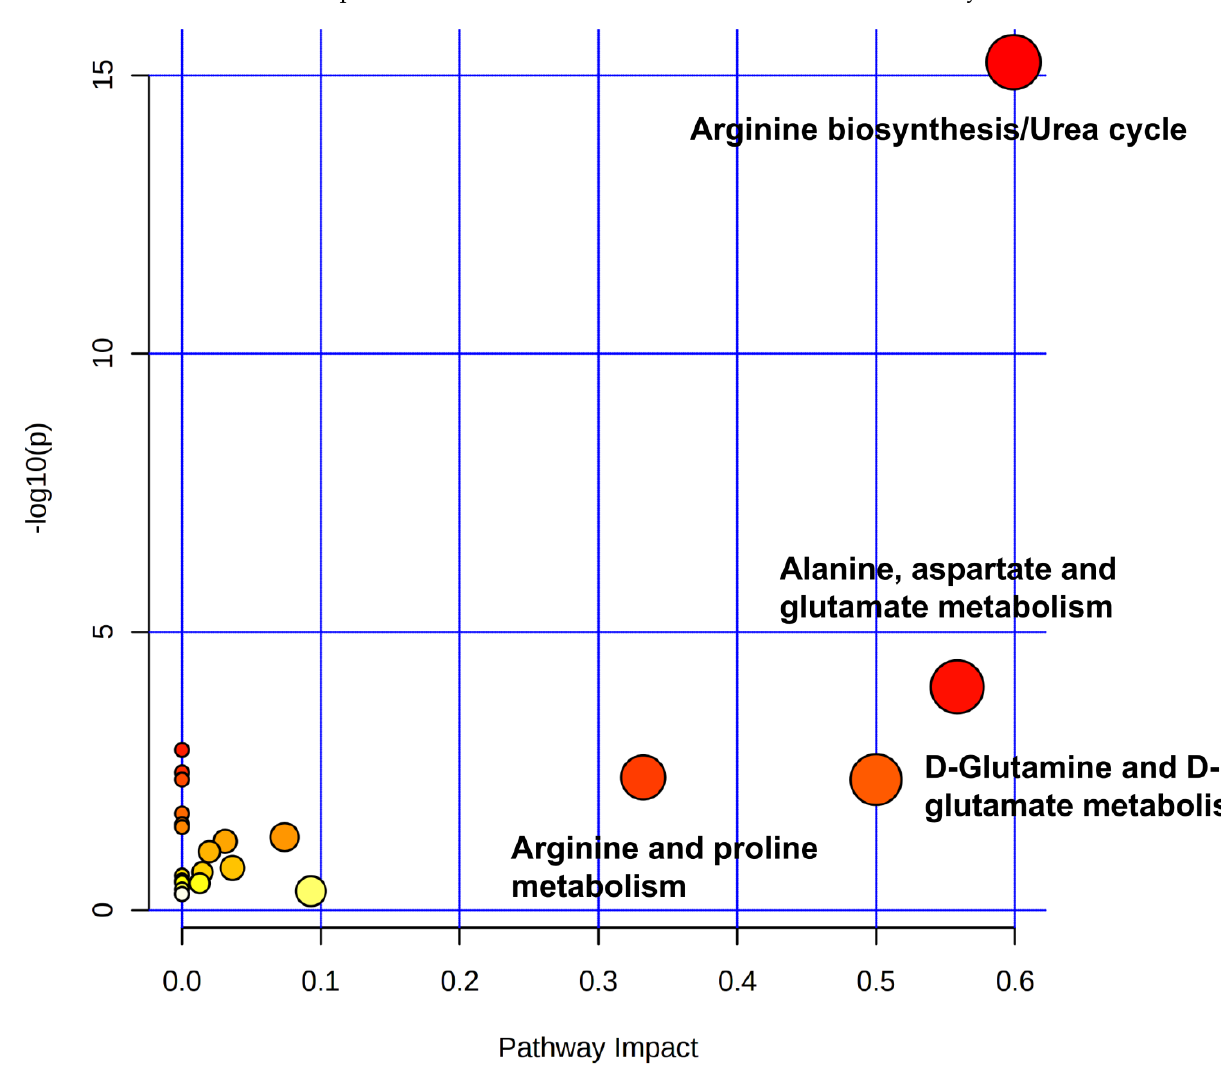
Figure 4. Metabolic pathway analysis by MetaboAnalyst. The pathway analysis was based on 41 unique metabolites. The x -axis represents the pathway impact value from pathway topology analysis, and the y -axis represents the -log p -value from pathway enrichment analysis. The node color and radius are based on p -value and pathway impact value, respec- tively.